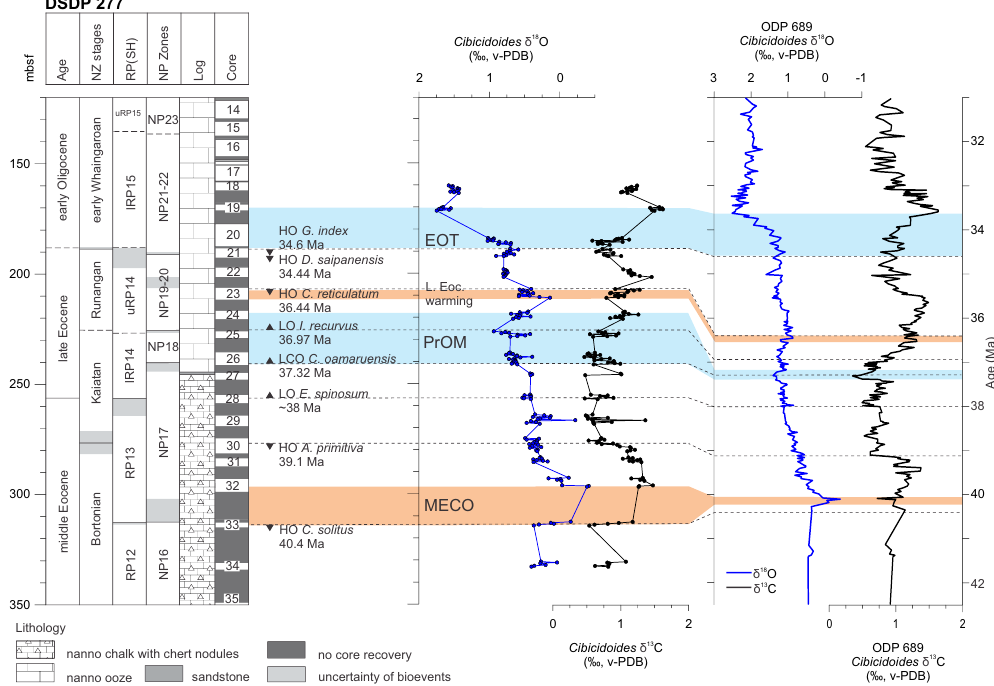
Figure 2. DSDP Site 277 stratigraphy, NZ stages (Raine et al., 2015), Southern Hemisphere radiolarian zones (RP), nannofossil zones (NP), lithology, core recovery, selected bioevents (ages calibrated to the 2012 geological timescale; Gradstein et al., 2012; Raine et al., 2015) and benthic δ 18 O and δ 13 C data of DSDP Site 277. The dashed lines correlate with Site 277 based on the ages of the bioevents to Southern Ocean Cibicidoides data of ODP Site 689 Hole B (Maud Rise) (Diester-Haass and Zahn, 1996) calibrated to the GTS2012 timescale using the magnetostratigraphy data of Florindo and Roberts (2005) and Spiess (1990). LO: lowest occurrence; LCO: lowest common occurrence; HO: highest occurrence; MECO: Middle Eocene Climatic Optimum; PrOM: Priabonian Oxygen Isotope Maximum; EOT: Eocene–Oligocene